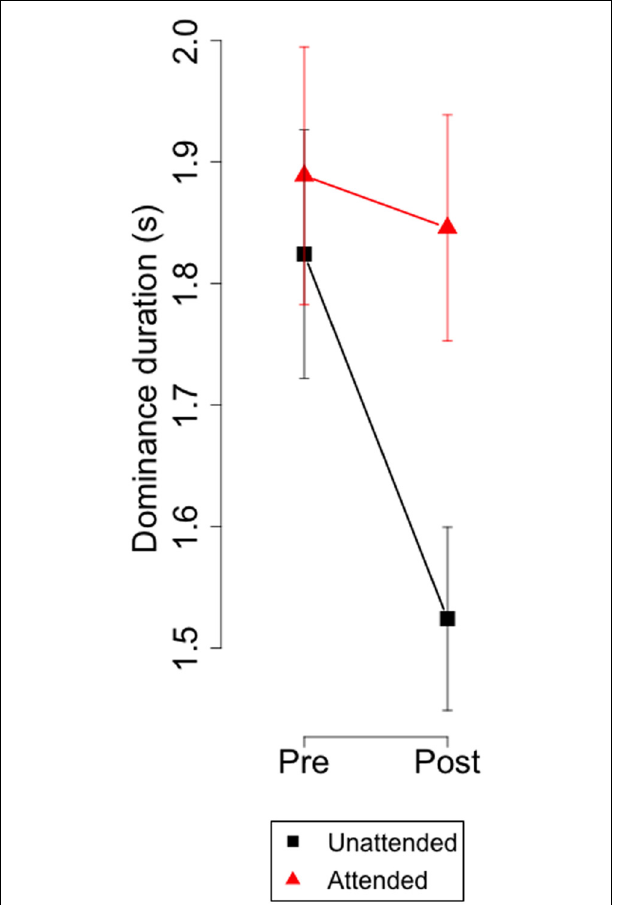
FIGURE 4 | Experiment 1. Group means and 95% confidence intervals of dominance durations for the attended and unattended channel before and after the monocular attentional task.